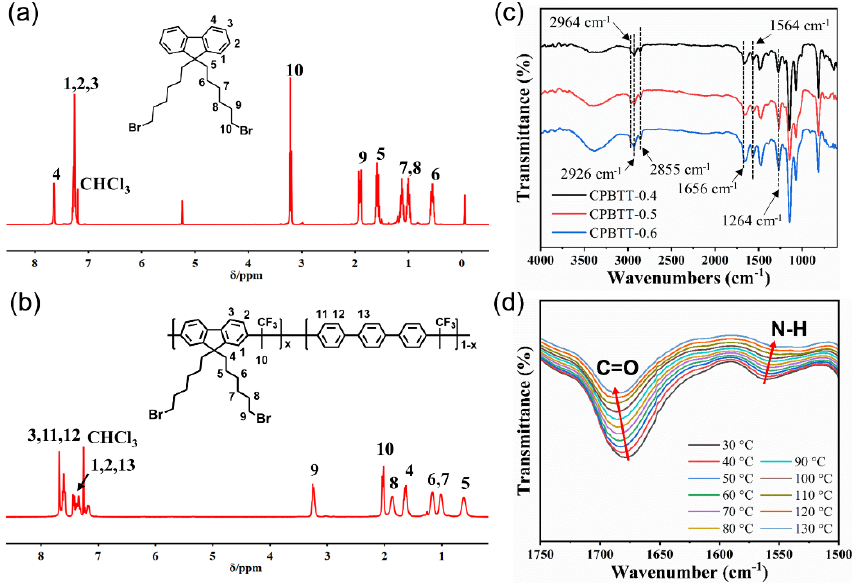
Figure 2. 1 H NMR spectra of ( a ) BBF monomer and ( b ) PBTT − x polymer backbone. ( c ) FTIR spectra of CPBTT − x membranes. ( d ) temperature − dependent FTIR spectra of CPBTT − 0.6